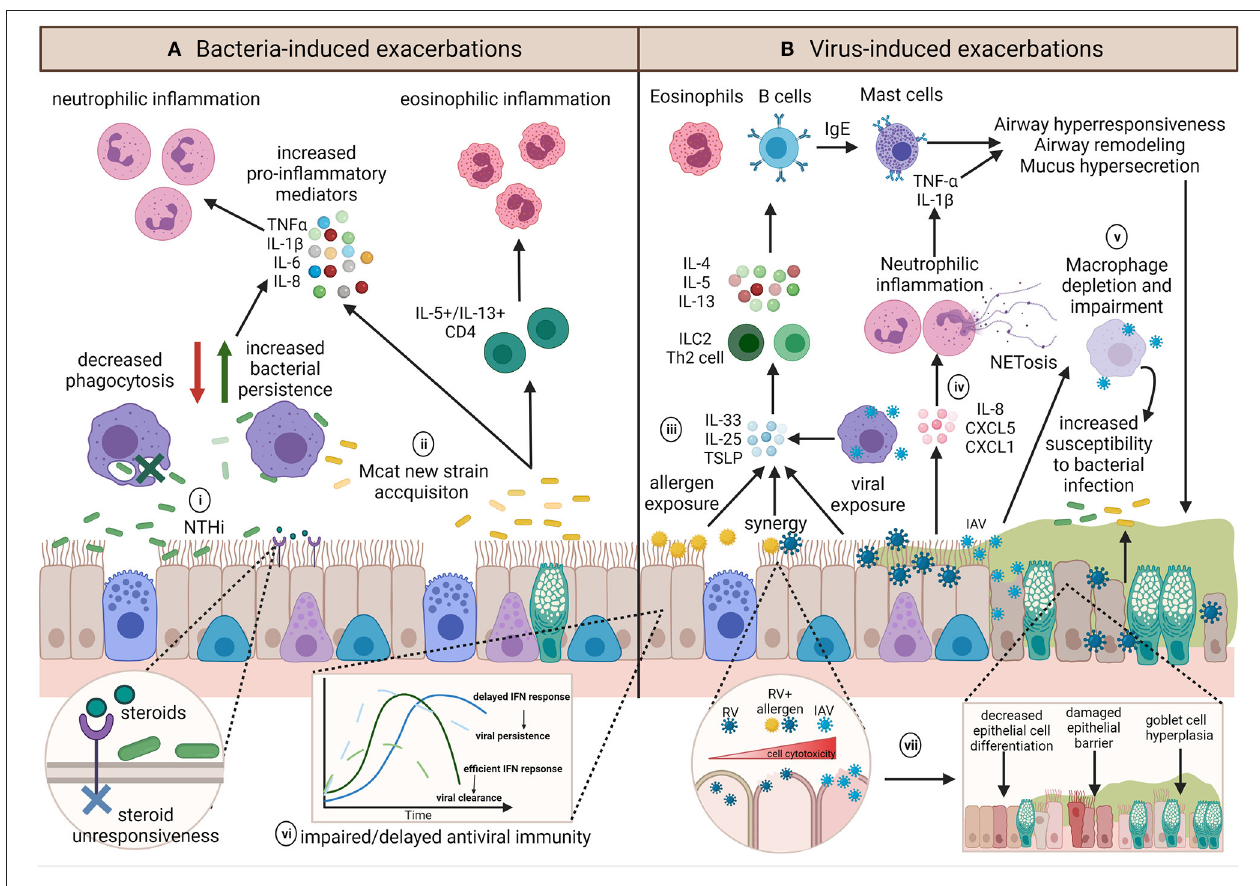
FIGURE 4 | Summary of the diverse potential mechanisms contributing to and influencing infection-induced exacerbations. (A) The role of bacteria in exacerbations are not well-known but inflammatory profiles associated with exacerbations appear to be pathogen dependent. (i) NTHi infection results in upregulation of pro-inflammatory mediators and is associated with persistent infection, neutrophilic inflammation and steroid-resistance. Chronic NTHi airway colonization may occur as a result of macrophage impairment in phagocytosis. (ii) On the other hand, exacerbations with Mcat are associated with acquisition of a new Mcat strain and is associated with both neutrophilic and eosinophilic inflammation. (B) Viral induced exacerbations can induce the hallmarks of asthma exacerbations through upregulation of T2 responses. (iii) Epithelial cells and macrophages contribute to IL-33, IL-25, and TSLP release, resulting in ILC2 or Th2 release of IL-4, IL-5, and IL-13 to upregulate eosinophils and B cells, which produce IgE and subsequently activate mast cells, all of which induce airway hyperresponsiveness, remodeling, and mucus hypersecretion. (iv) Conversely, some viruses have been shown to induce IL-8, CXCL5, and CXCL1 release, resulting in neutrophilic inflammation and epithelial damage via neutrophil production of NETs. (v) Influenza infection can impact on macrophage function or result in macrophage depletion, which along with mucus plugging, and may render the airway susceptible to persistent bacterial infection, and may further act to exacerbate airway inflammation. Underlying host factors such as (vi) impaired host antiviral immunity may result in an altered baseline immune profile that contributes to a dysregulated host response, whereas (vii) allergen sensitization or exposure may synergistically augment inflammation and increase cell lysis and damage during viral infection. Created using